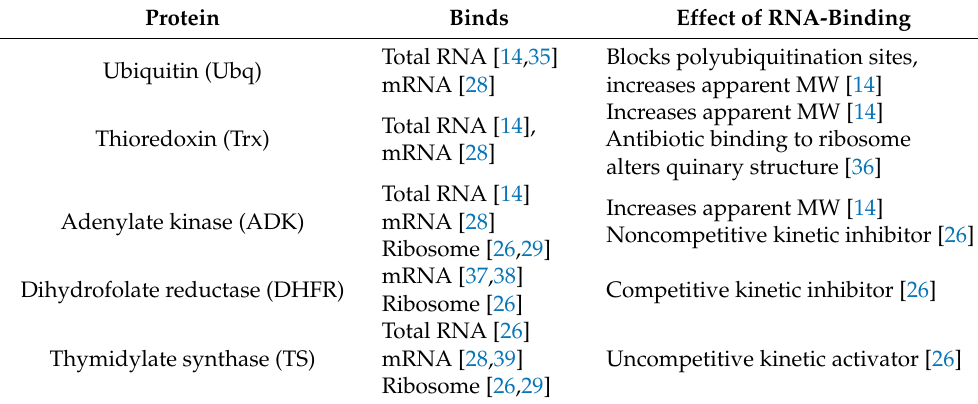
Table 1. Summary of protein quinary